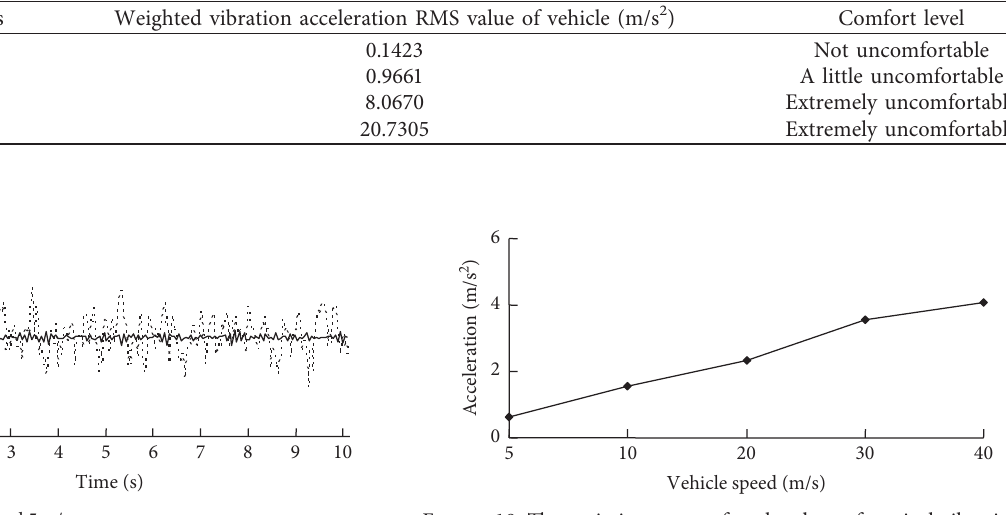
Table 2: The effects of road roughness on the vehicle ride comfort.